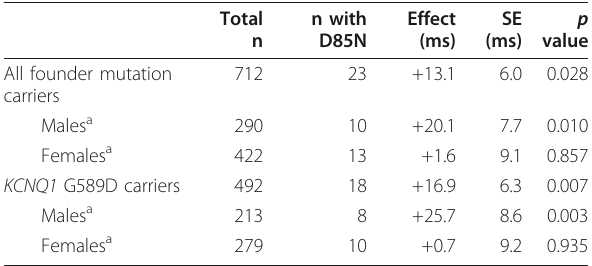
Table 2 Effect of KCNE1 D85N on age-, sex-, and heart rate-adjusted QT interval Total